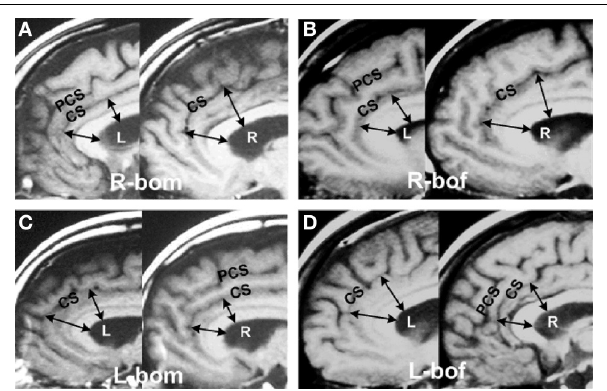
FIGURE 1 | Asymmetries in the anterior cingulate cortex. Example of MRI sagittal images taken from 149 hemisity-calibrated subjects. (A) Right brain-oriented male (R-bom, RM). (B) Right brain-oriented female (R-bof, RF). (C) Left brain-oriented male (L-bom, LM). (D) Left brain-oriented female (L-bof, LF). Pairs of arrows reaching from the lower surface of the central white corpus callosum (CC) to the cingulate sulcus (CS) illustrate four measurements made for each subject. CC thickness was the same on images from either side. PCS refers to the paracingulate sulcus. Note that the arrow lengths are longer on the right side for RPs and left side for LPs. From Morton and Rafto